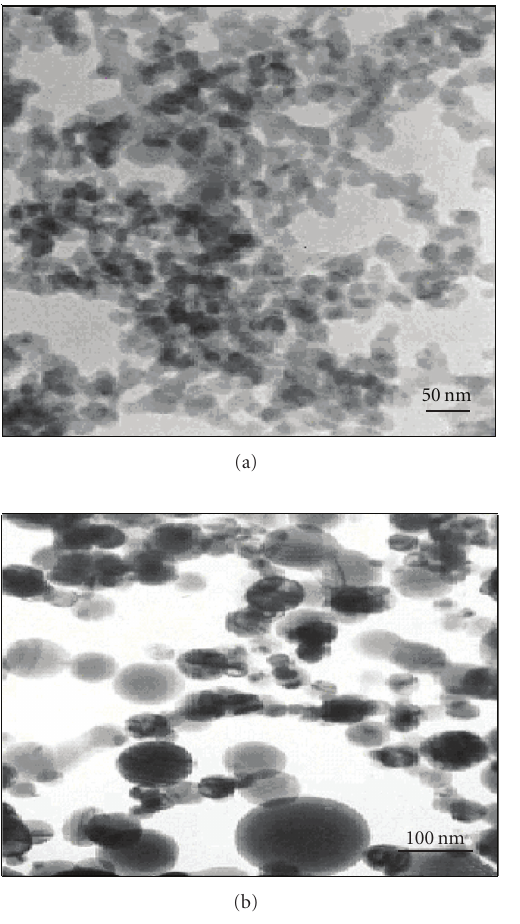
Figure 1: The image of primary particle Al powder (measured with TEM) (a) 35nm (b) 100nm.